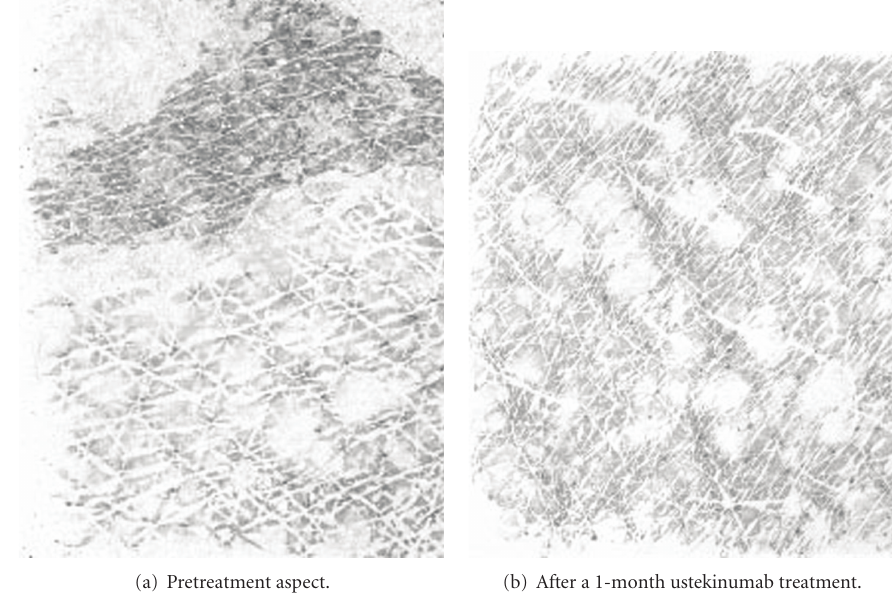
Figure 1: Skin capacitance mapping of a psoriatic lesion, showing a patchwork of white hyperkeratotic areas and a darker inflammatory area (surface area: 18 ∗ 12 . 8 mm).